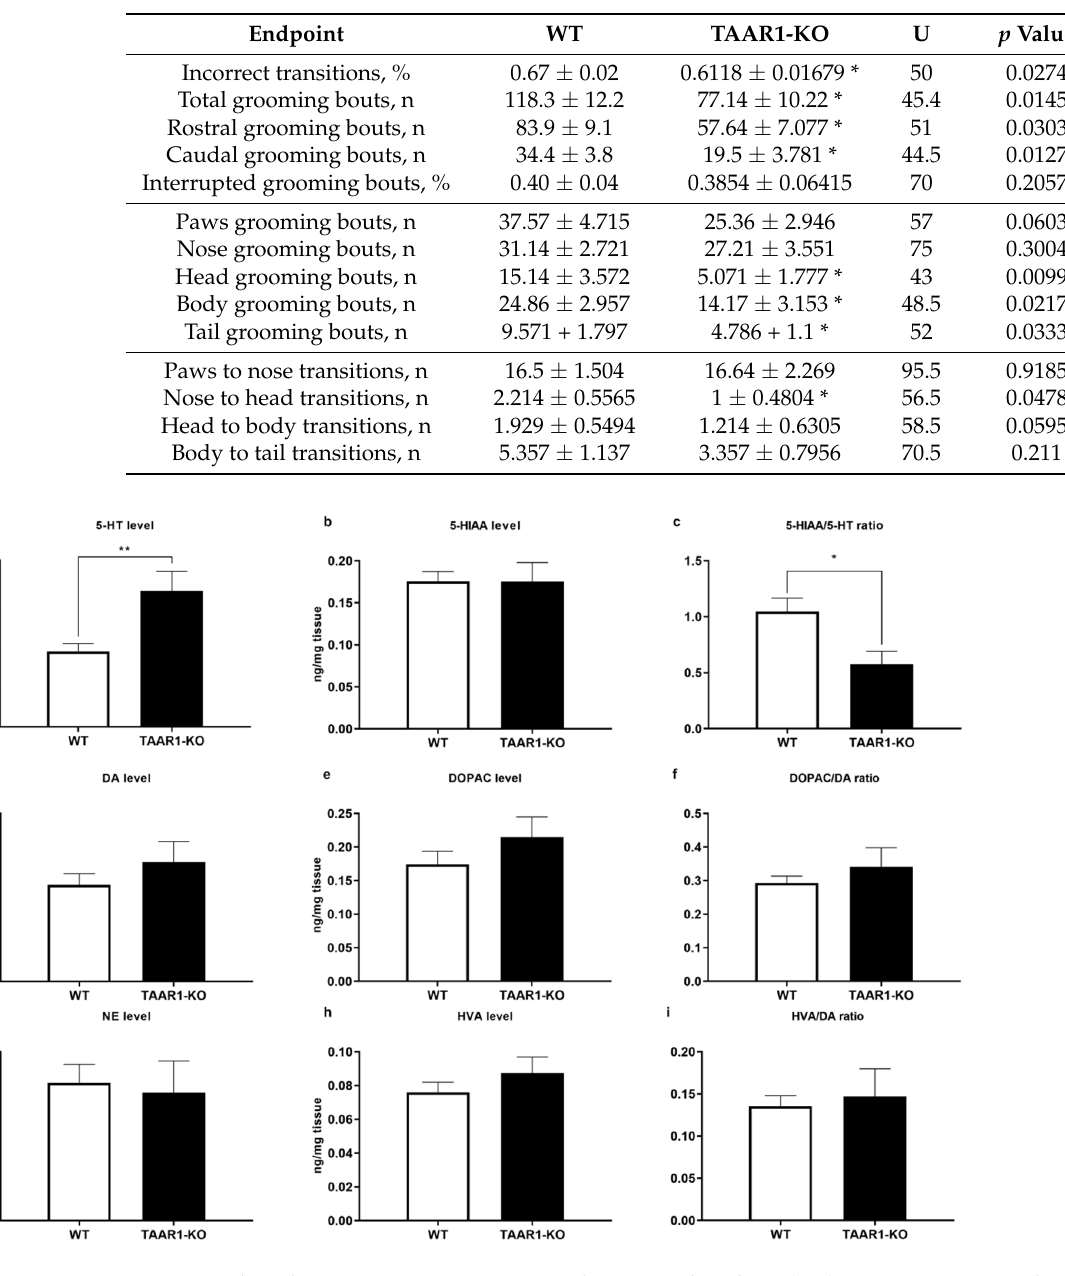
Table 1. Summary of statistical results of TAAR1 knockout (KO)-induced behavioral changes in mouse self-grooming test and self-grooming microstructure analysis. WT—wild type control mice. Data are presented as mean ± SEM (n = 14). * p < 0.05 vs. control, Mann–Whitney U-test.